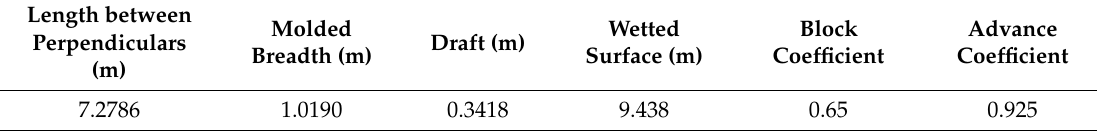
Table 1. Main parameters of the KCS model.